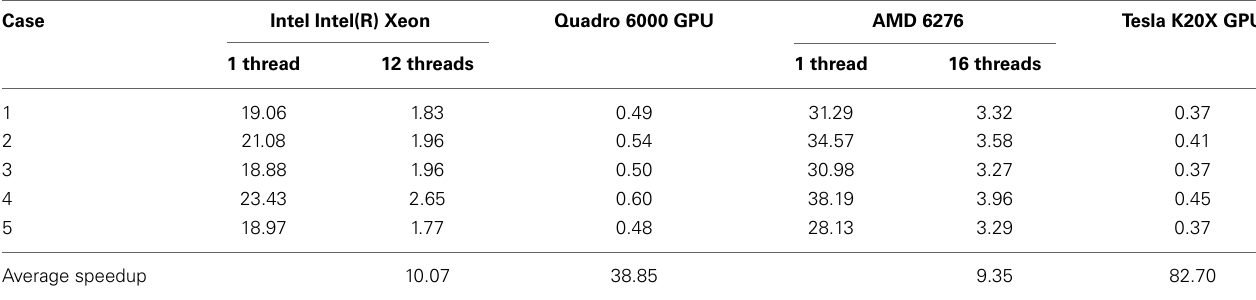
Table 4 | Block matching running time (second) using CPU and